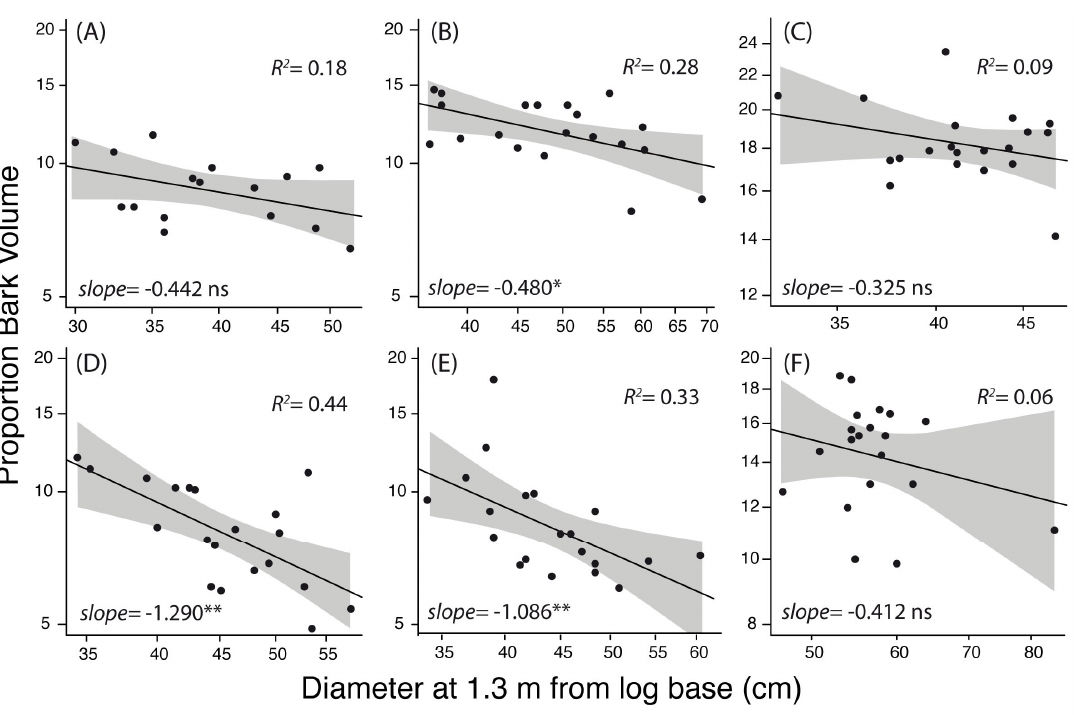
Table 2. Sample sizes and descriptive statistics per species regarding diameter at 1.3 m from the log base ( D b ), log length, and bark thickness.